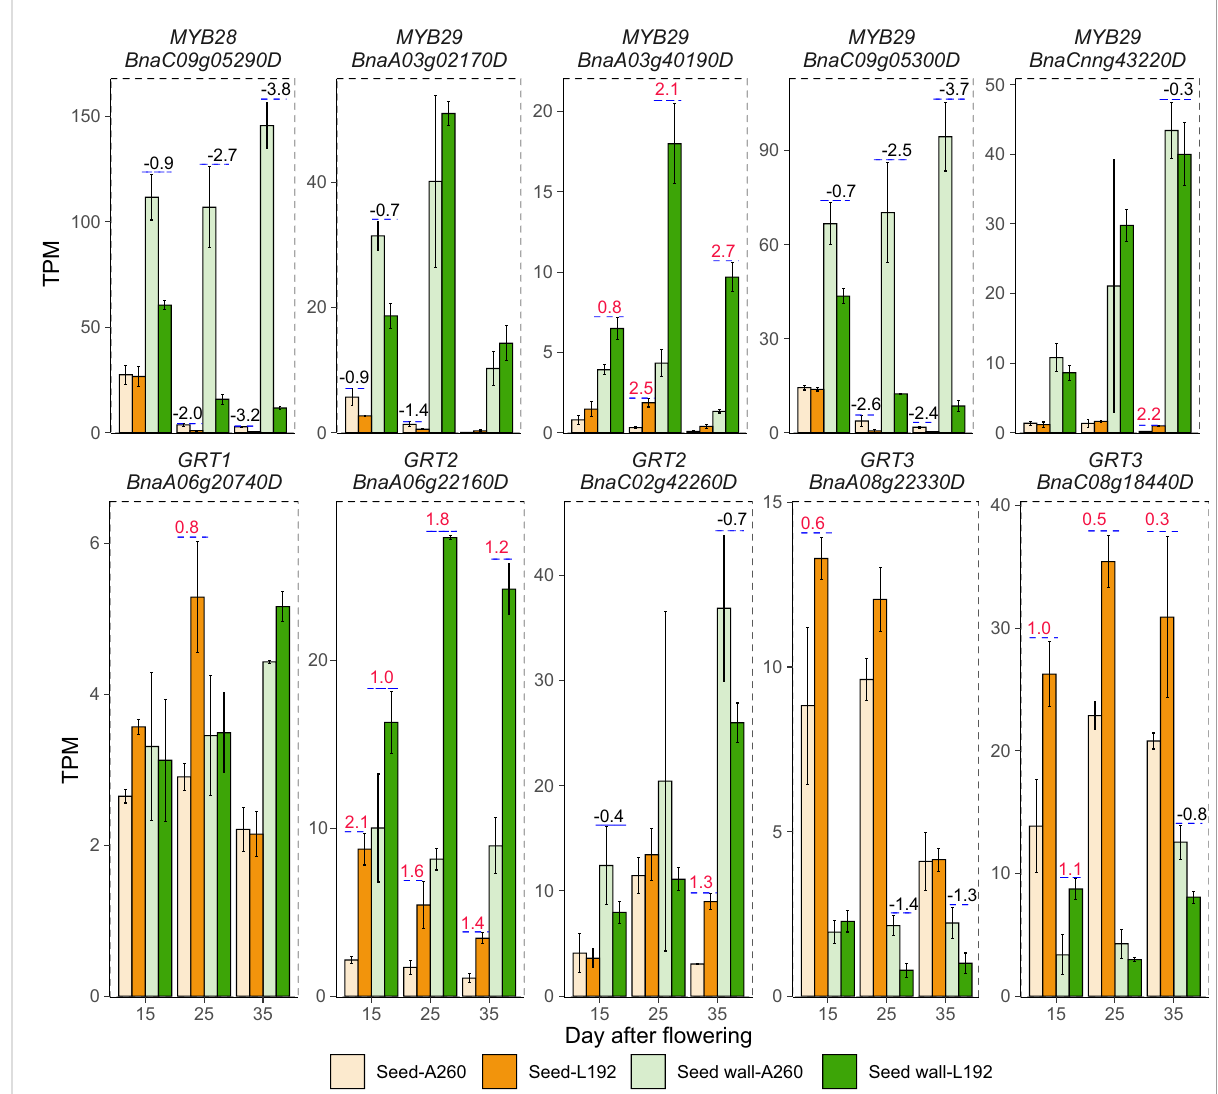
FIGURE 7 Expression of the main genes relative to glucosinolate between L192 and A260. The bars represent the means of three biological replicates (TPM value), error bars are the standard deviation, and the numbers on the bars are the logFC (FC, fold change, comparison of L192 versus A260). 15, 25 and 35, 15, 25 and 35 days after fl owering,